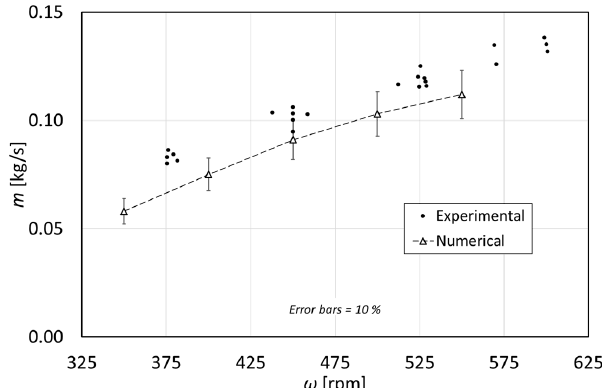
Figure 7. Model validation: comparison between the experimental data (taken from Bianchi et al. [21]) and the numerical results.